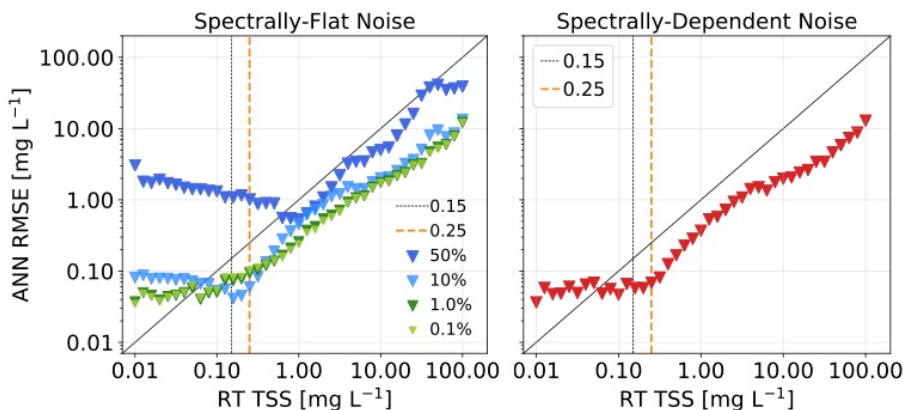
Figure 11. Retrieval RMSE errors (in mg L − 1 ) for spectrally flat ( left panel ) and spectrally dependent ( right panel ) photon noise levels. Radiative transfer (RT) TSS and associated RMSE values are presented in logarithmic scale. The vertical dashed line at 0.15 mg L − 1 is the detection limit adapted from Dorji and Fearns [17], 2018. The vertical dashed line at 0.25 mg L − 1 is the detection limit of the present method.